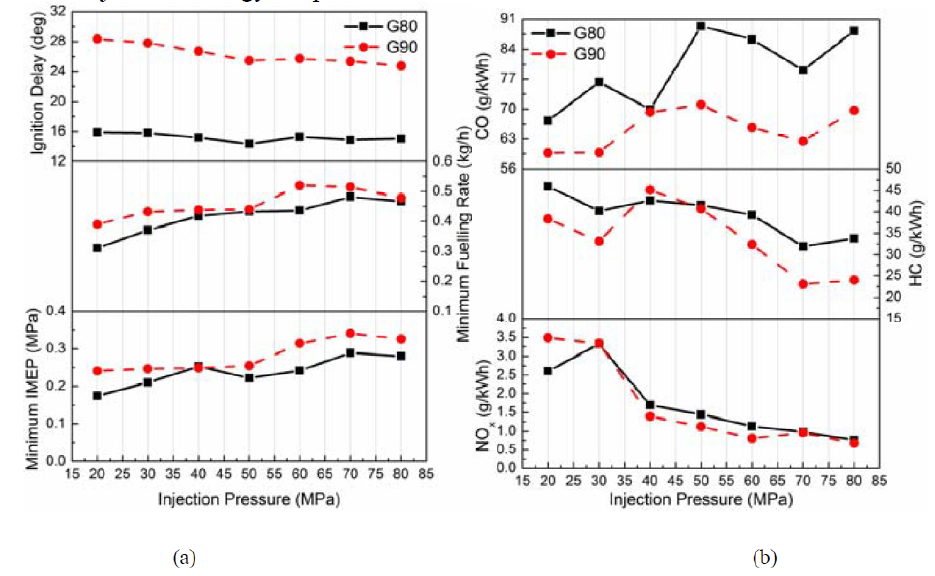
Fig. 17 Comparison of combustion performance and emissions between GP80 and GP90 [98].